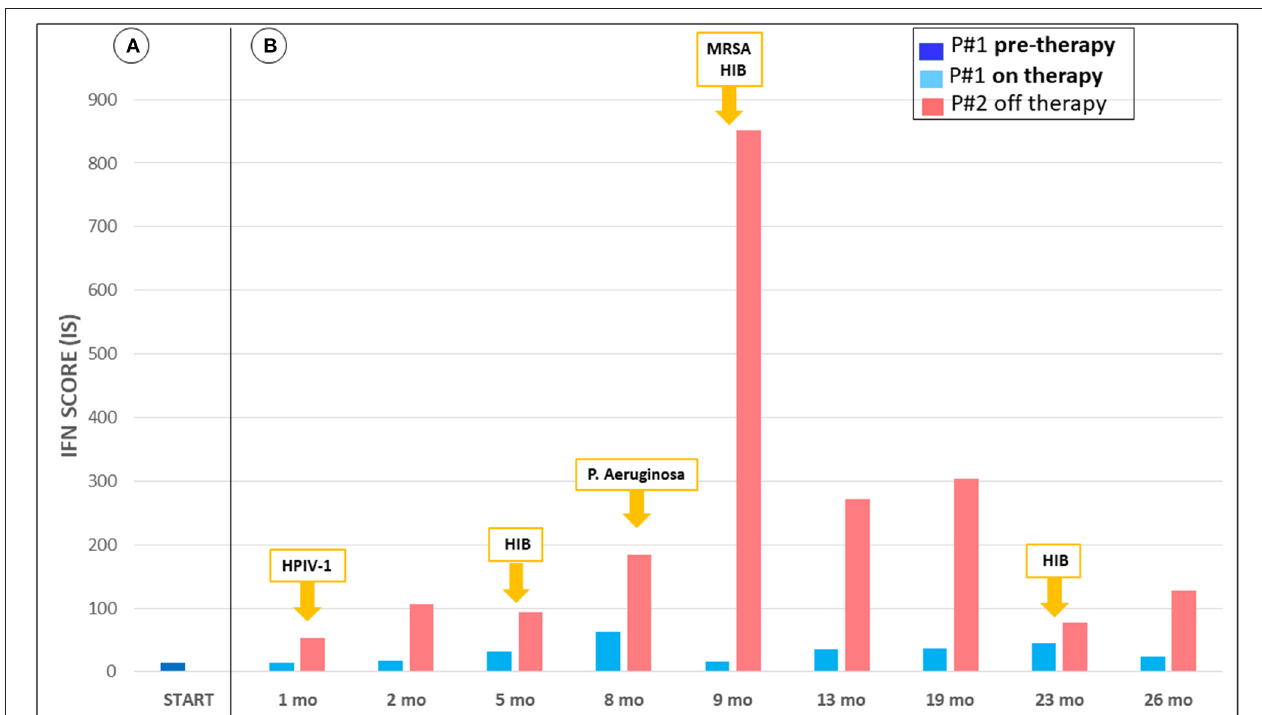
FIGURE 2 | Trend of interferon-signaling gene expression score from June 2018 to August 2020. (A) IFN score P#1 pre-therapy, not available measurement of P#2. (B) IFN score during treatment of P#1, in parallel with P#2, and report of simultaneous respiratory infections. P#1 shows mild increment of IFN score during infections, while P#2 presents significant increments. Also, during infection free periods, there is discrepancy of the values. The interferon score was calculated as the median fold changes of expression of a panel of interferon-stimulated genes (ISGs: IFI27, IFI44L, IFIT1, RSAD2, ISG15, and SIGLEC1). The gene expression was analyzed by quantitative reverse transcription polymerase chain reaction (qPCR) using 18s as gene housekeeping to normalize the results. Relative quantification (RQ) was calculated with the formula 2 − 11 Ct , using as calibrator a pool of 17 healthy controls. The mean interferon score of the healthy donors plus two standard deviations above the mean was calculated. Scores higher than this value (4.67) were designated as